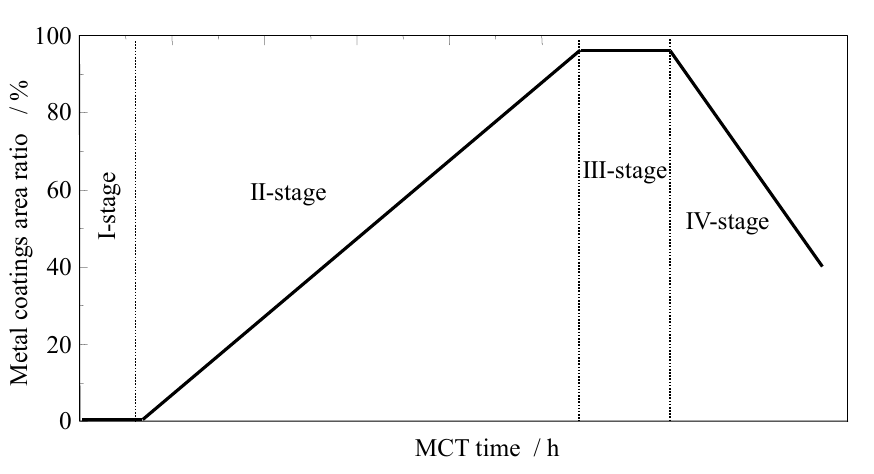
Figure 20. Formation process of metal coatings by